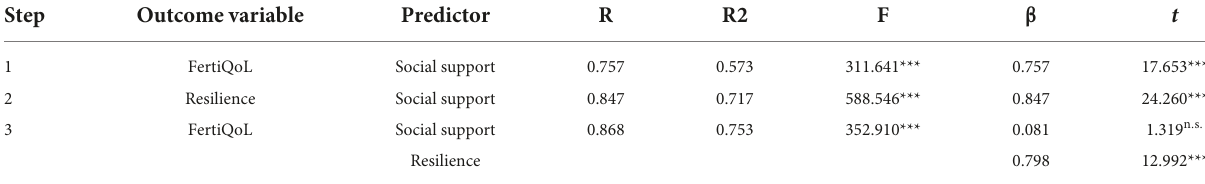
TABLE 4 The regression results of the effects of perceived social support and resilience on fertility-related quality of life (FertiQoL). Step